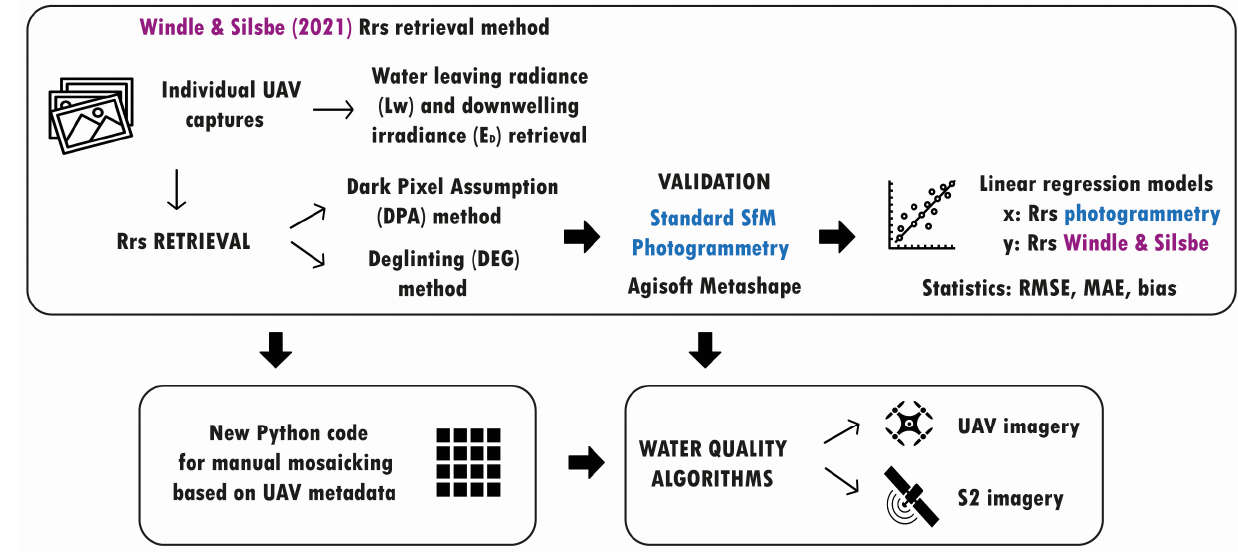
Figure 2. Methodological workflow followed in the present study